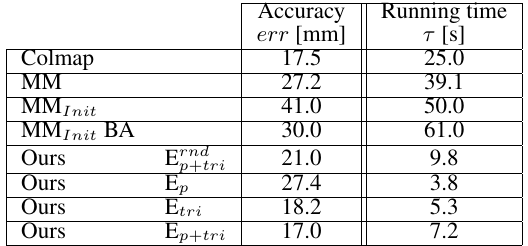
Table 5. Strecha benchmark. Running times τ in conjuction with the results presented in Table 4. Note that the times for Ours concern only the BA step. Times markes with ( ∗ ) correspond to the total incremental SfM.